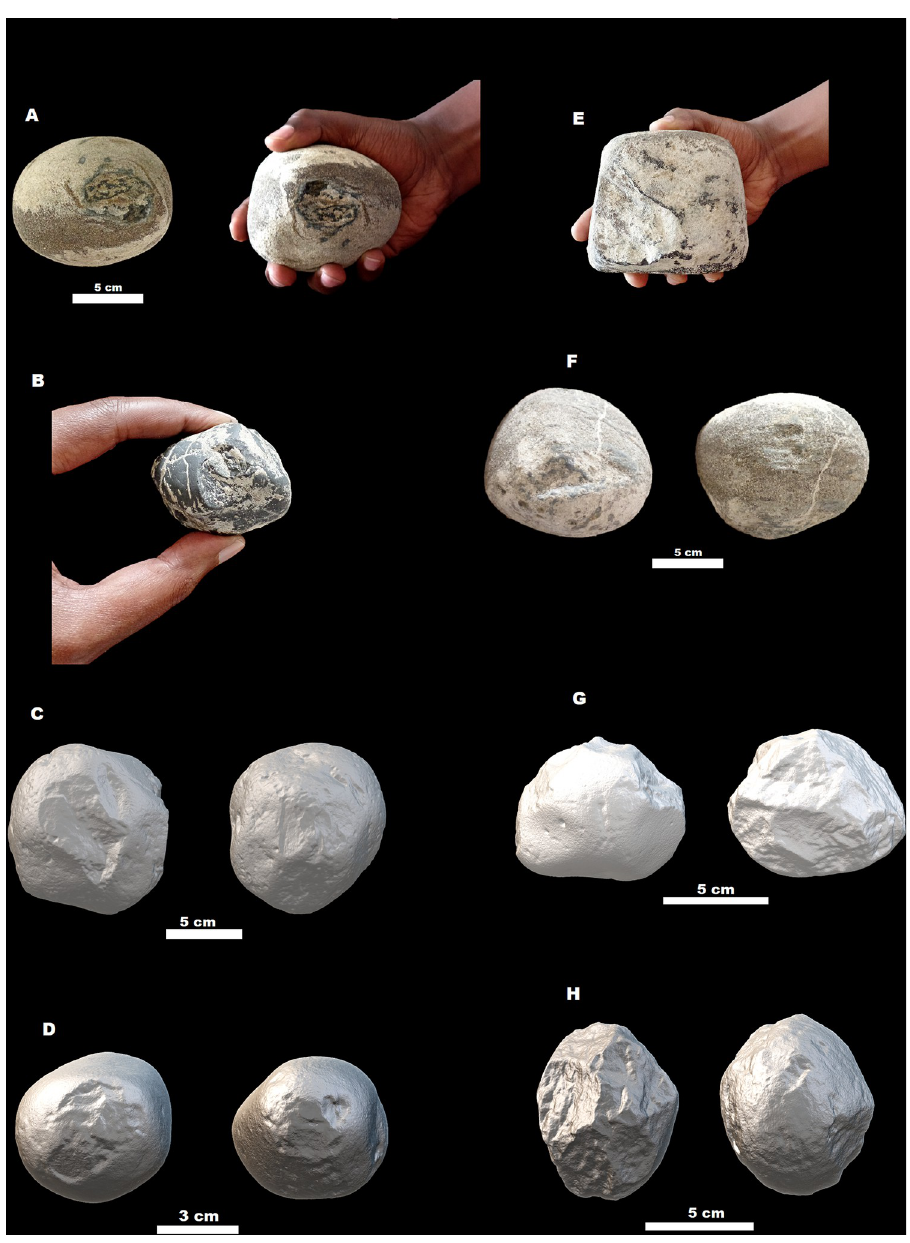
basalt. (C) is made on glassy